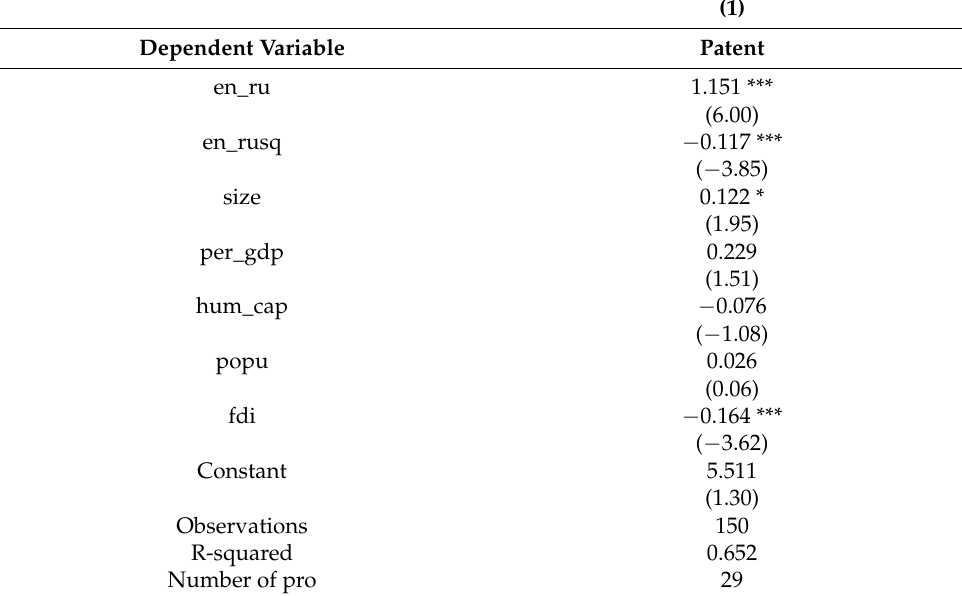
Table 8. The robust